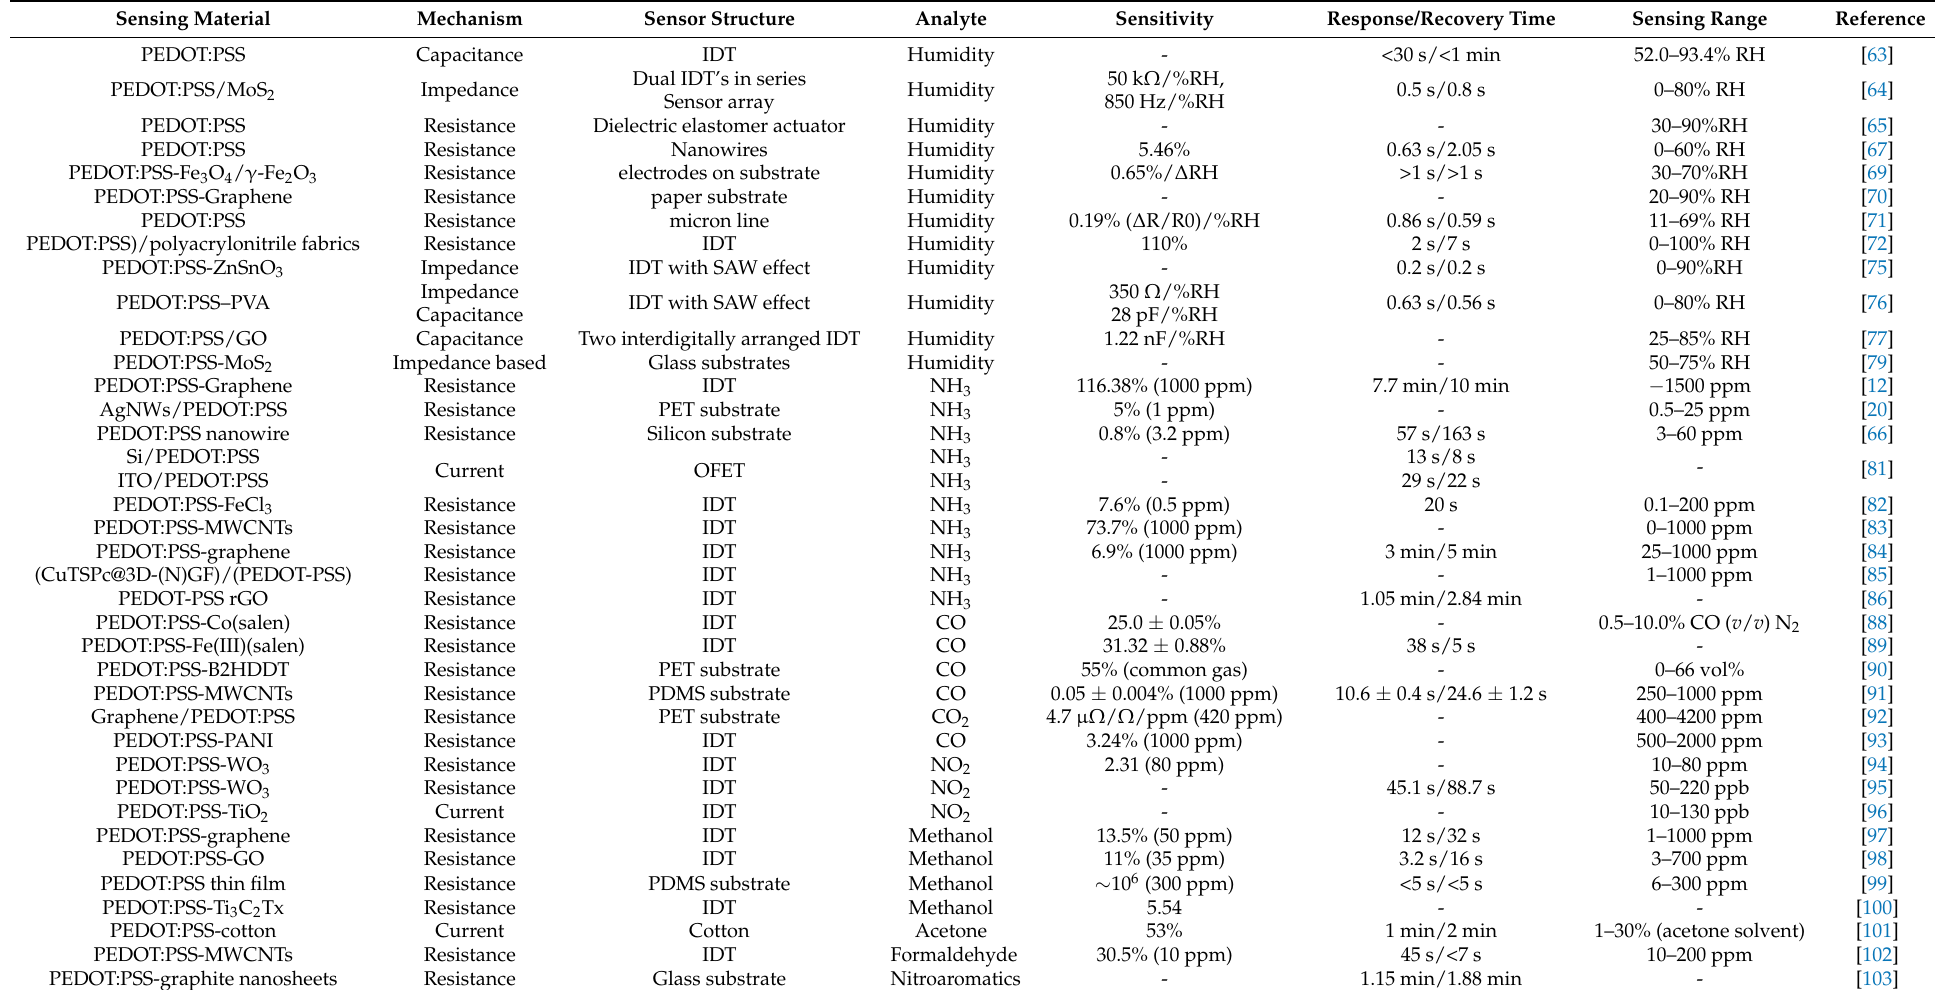
Table 2. Comparison of PEDOT:PSS-based electrical chemosensors for different